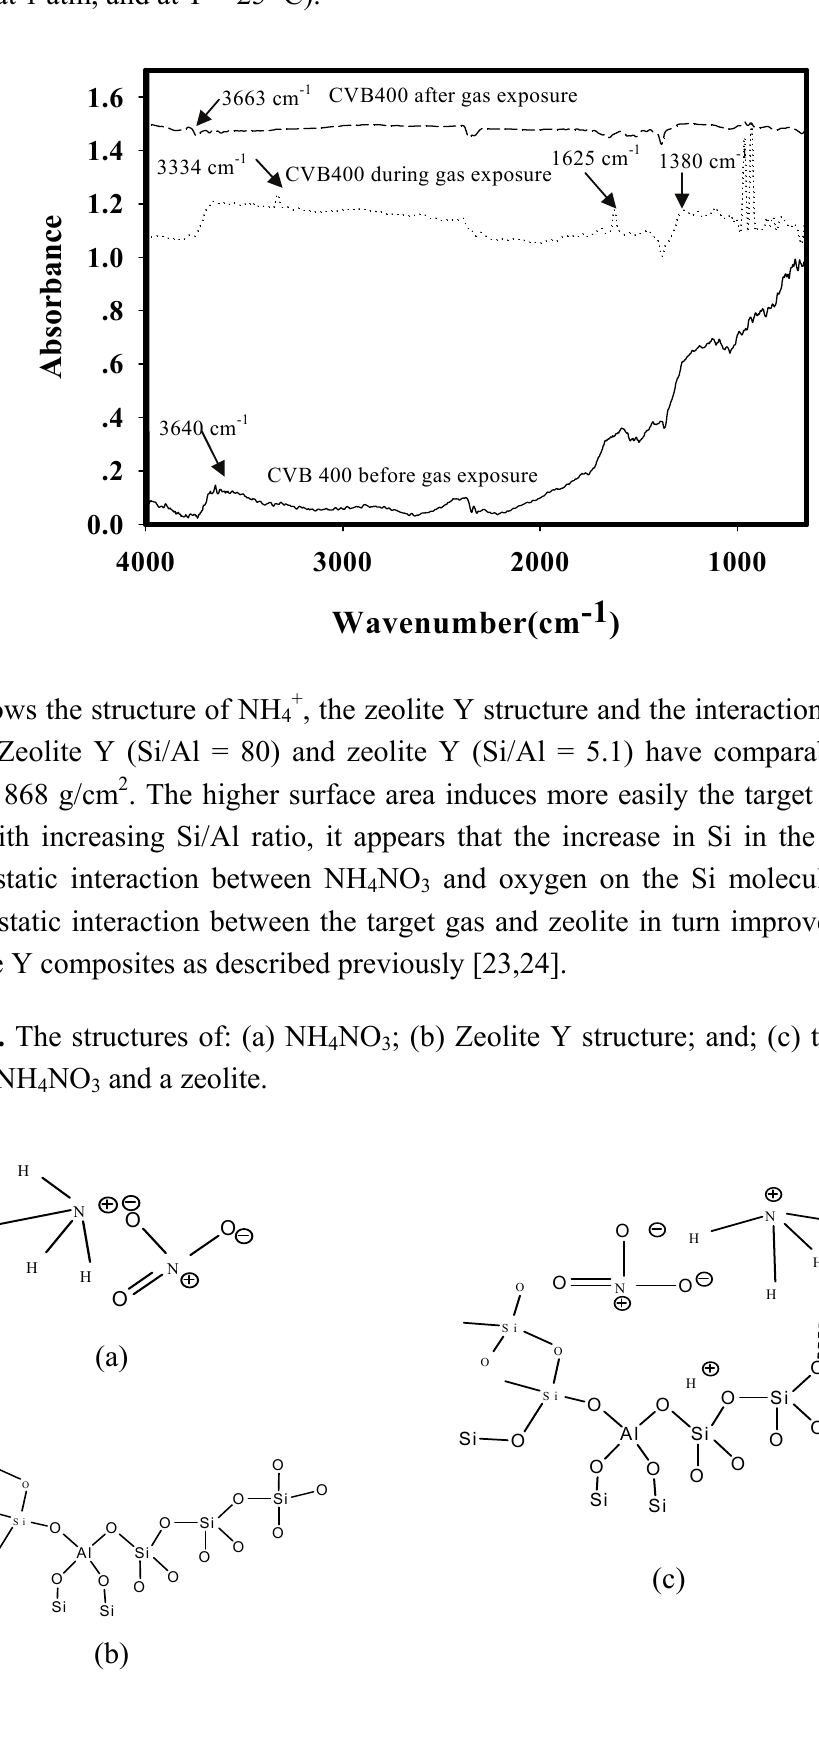
NO (NH NO = 377 ppm, 4 3 4 3